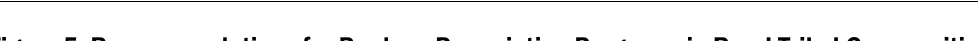
Figure 5. Recommendations for Produce Prescription Programs in Rural Tribal